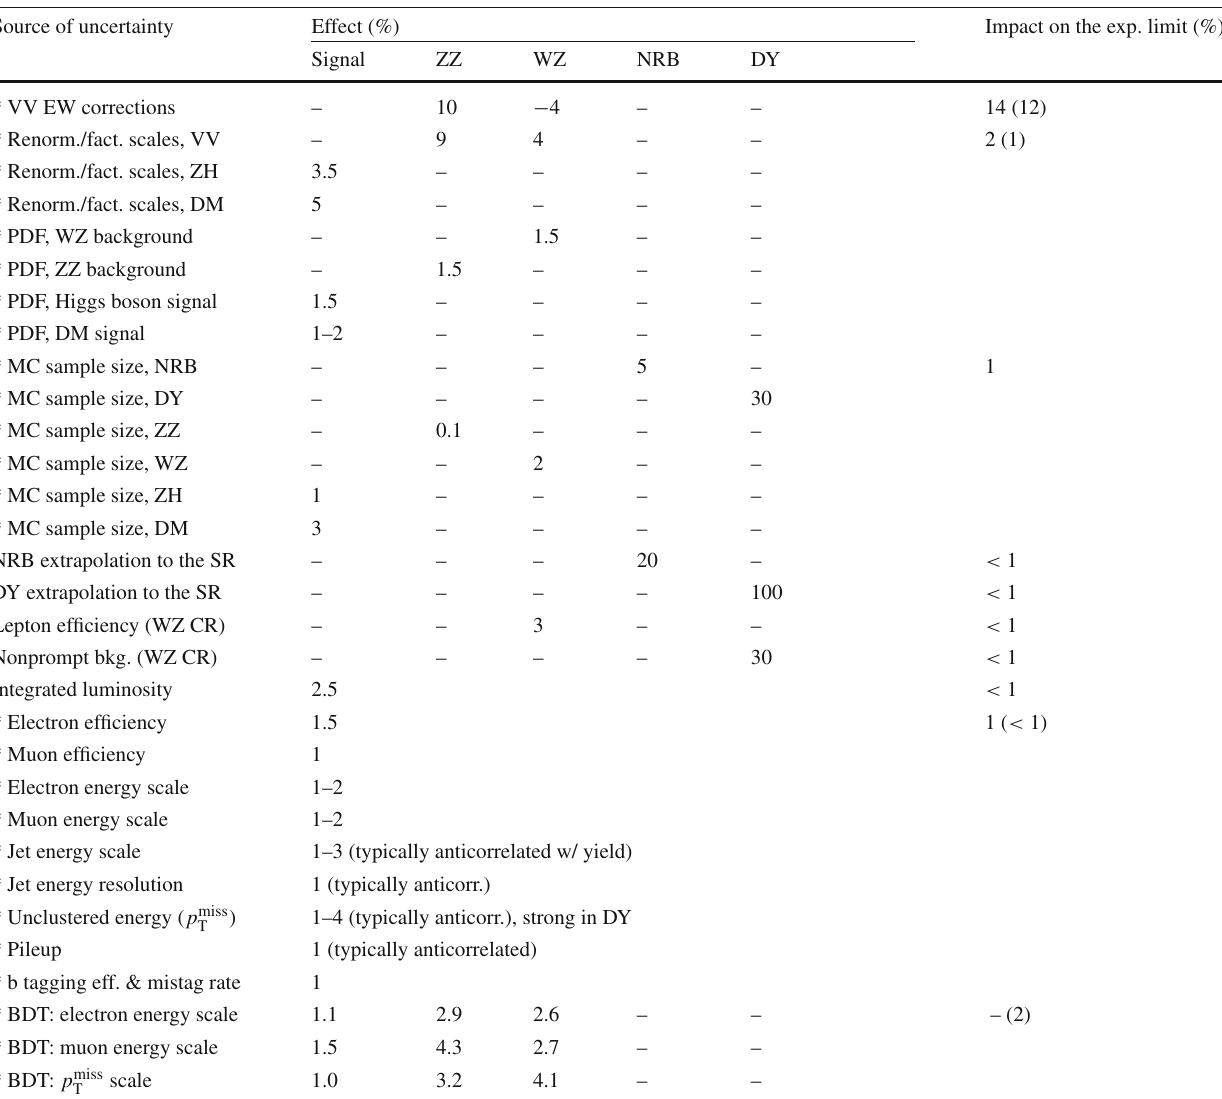
Table 2 Summary of the systematic uncertainties for the p miss BDT-based analyses. Each uncertainty represents the variation of the relative yields of the processes in the SR. Each uncertainty is fully correlated across processes to which it contributes, including those pro- cesses that are also present in CRs. The symbol “–” indicates that the systematic uncertainty does not contribute or is deemed negligible. For minor backgrounds, systematic uncertainties are omitted because of the smallness of their contribution. For shape uncertainties (indicated with a *), the numbers correspond to the overall effect of the shape variation